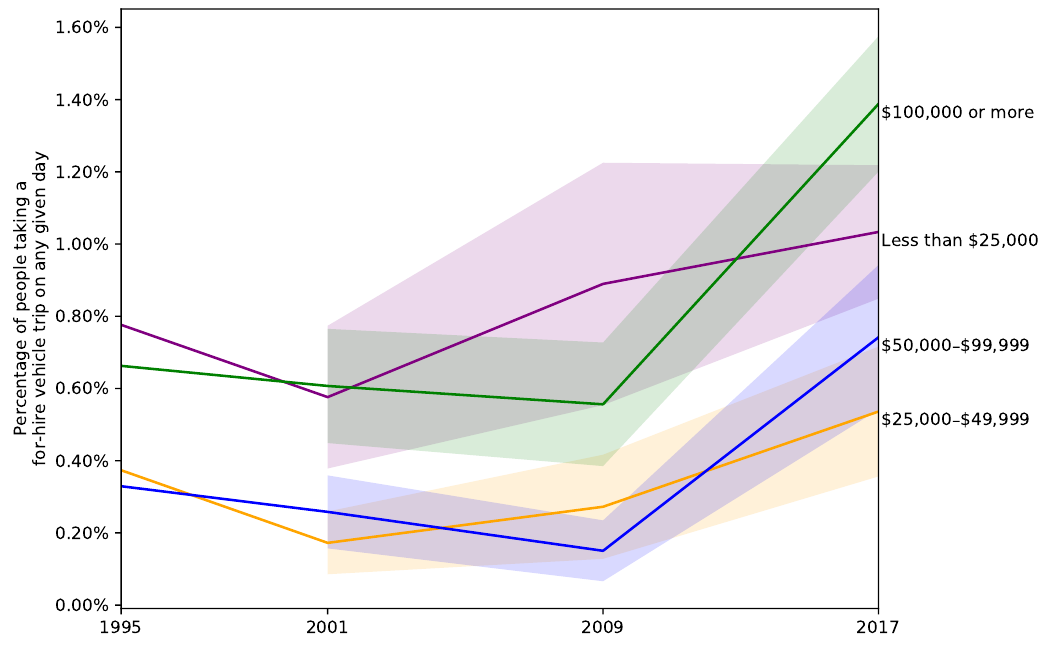
Figure 4. Trends in percentage of Americans using a for-hire vehicle on a given day, by annual household income (shaded areas represent 95% confidence